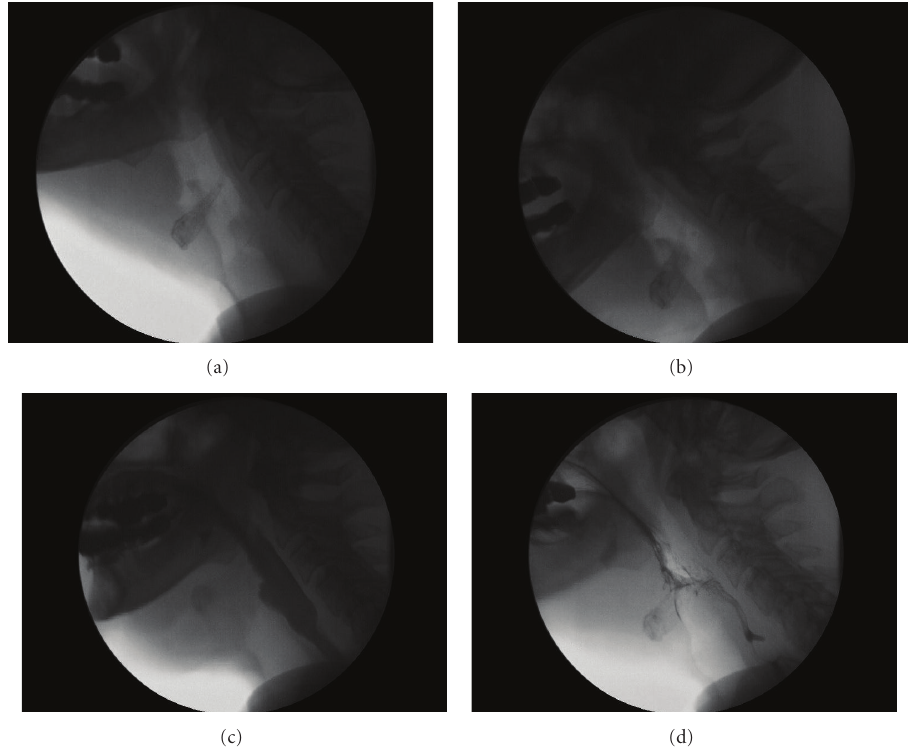
Figure 5: Case report 1. Male, 51. Right vocal fold epidermoid carcinoma with impaired mobility extending to the anterior commissure. The patient received a supracricoid laryngectomy with cricohyoidoepiglottopexy. A late 6-month videofluoroscopic control is shown. (a) Postsurgical anatomy at rest. The distance between the hyoid bone and the trachea is reduced while vocal folds are missed. The new laryngeal sphincter is sensibly shorter in the anterior-posterior direction. (b) Chin-to-chest maneuver to start the swallow (notice the contrast in the oral cavity). (c) The swallow is e ff ective. (d) Although there is some residue, the patient shows no aspiration (the swallow is